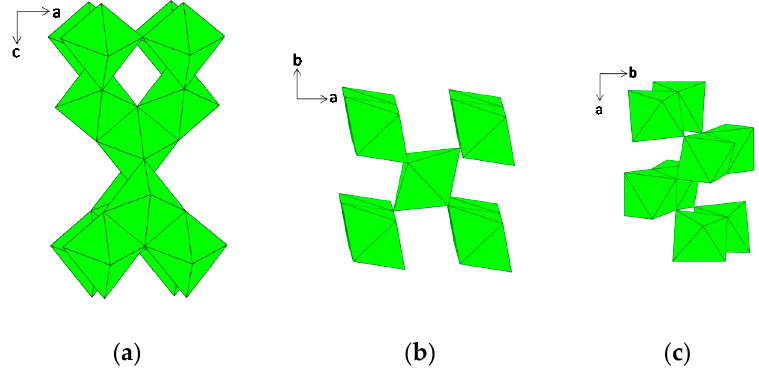
Figure 3. Structures of titania polymorphs: ( a ) anatase; ( b ) rutile; ( c ) brookite.